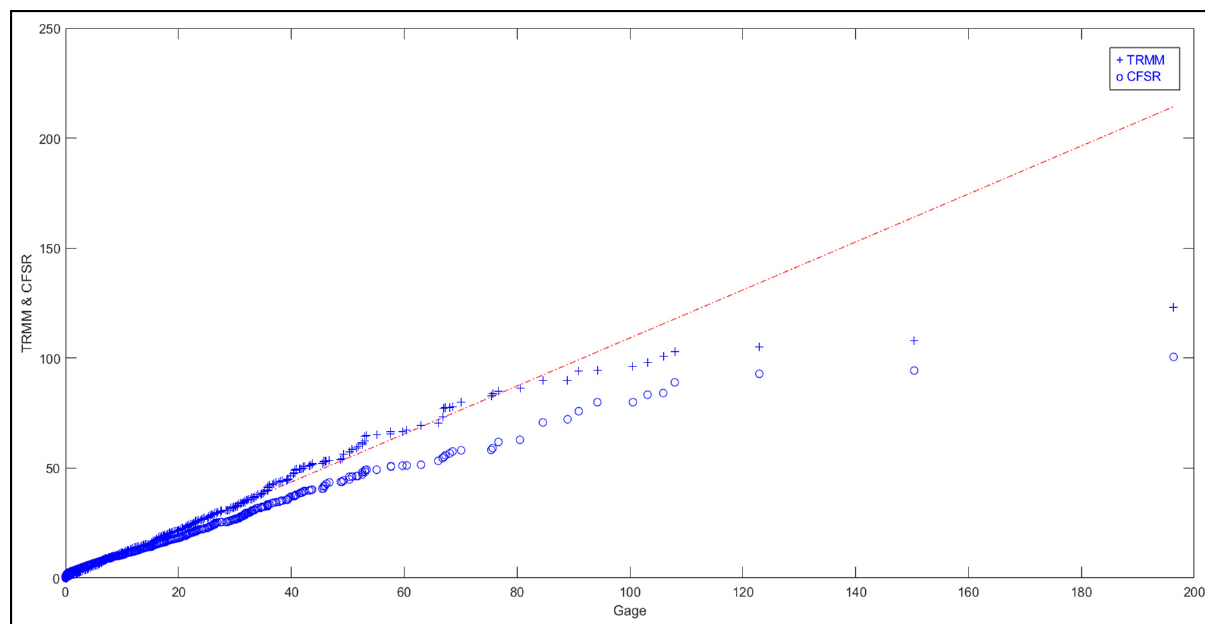
Figure 5. TRMM and CFSR data are plotted against observed weather station (Gage) data to observe the trend on a daily time